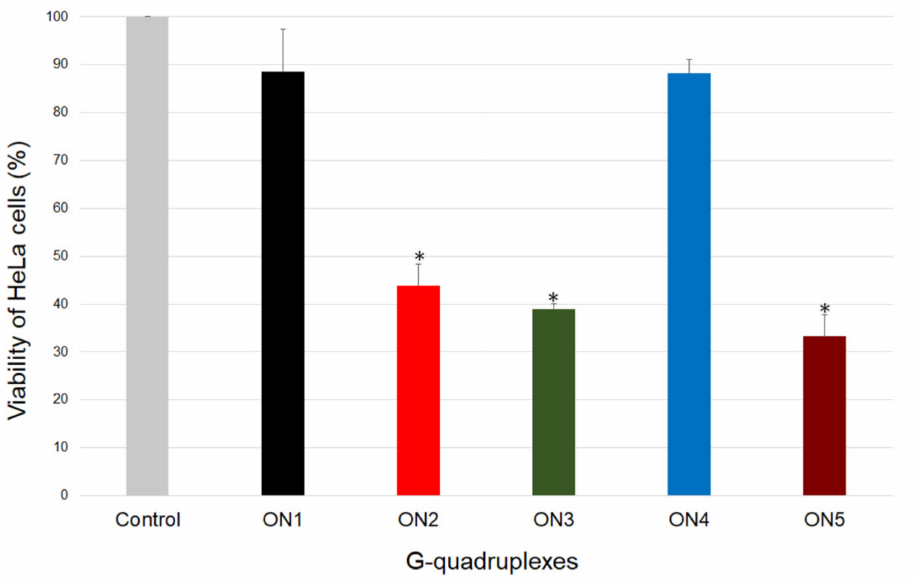
Figure 4. Antiproliferative activity of the oligonucleotides ON1 to ON5 studied at 10 µ M. HeLa cells cultured without oligonucleotides constituted the control. * p < 0.001 by one-way